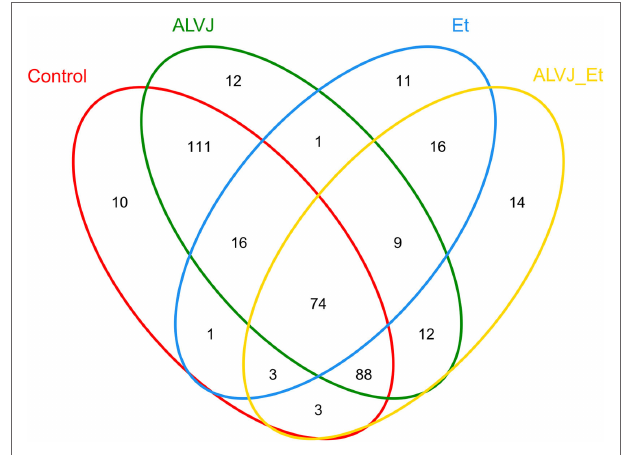
FigUre 2 | Venn diagram illustrating shared and unique operational taxonomic units (OTUs) from different infectious groups. Numbers below groups indicate the number of OTUs within each